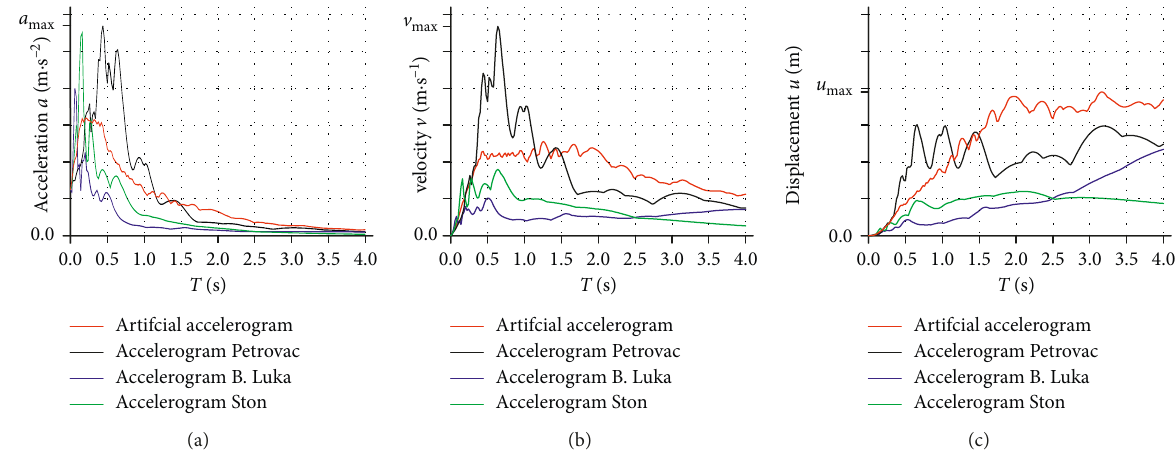
Figure 7: Elastic response spectra for applied accelerograms. (a) Spectral acceleration. (b) Spectral velocity. (c) Spectral displacement.